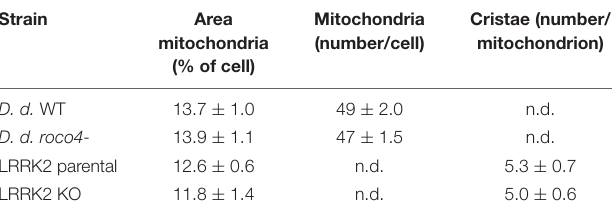
TABLE 1 | Quantification of mitochondria and cristae mitochondria.